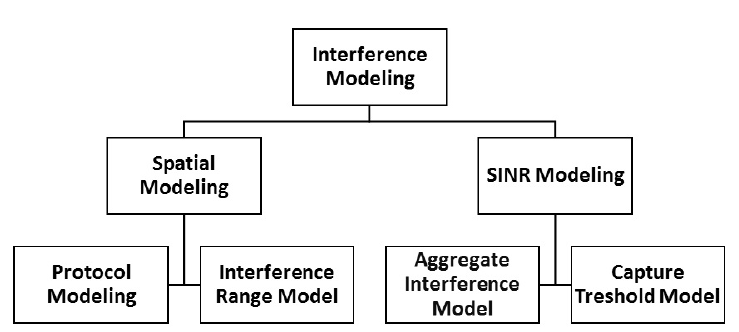
Figure 4. Classification of interference-identifying techniques.